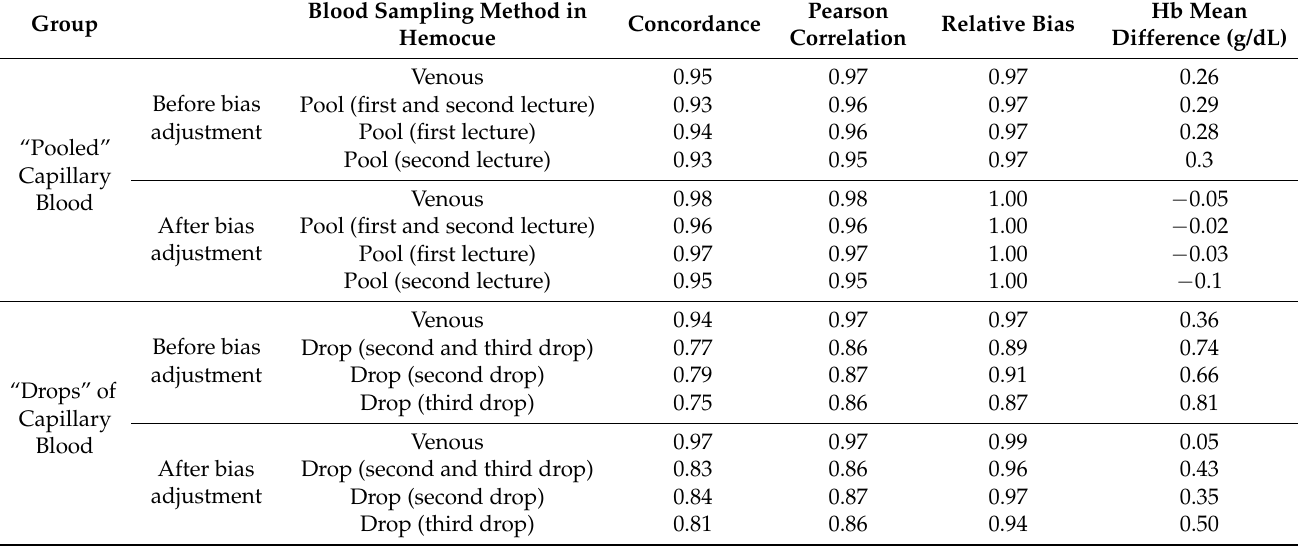
Table 2. Comparative results of differences in Hb concentrations by blood sample sources analyzed us- ing the HemoCue 201+ versus venous blood samples analyzed using the cyanmethemoglobin